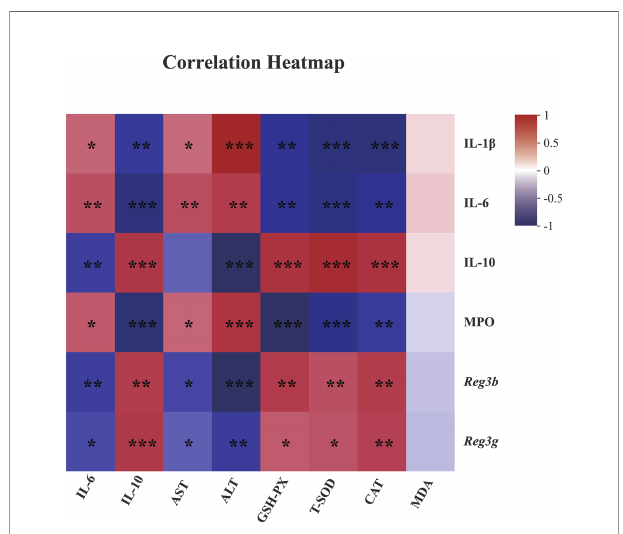
FIGURE 7 | Spearman correlation between anti-in fl ammatory or anti- oxidative parameters of colonic tissues (vertical axis) and hepatic tissues (horizontal axis) in dextran sulfate sodium-treated mice. The red color denotes a positive correlation, while the blue color denotes a negative correlation. The intensity of the color is proportional to the strength of the Spearman correlation. * P ≤ 0.05, ** P ≤ 0.01, *** P ≤